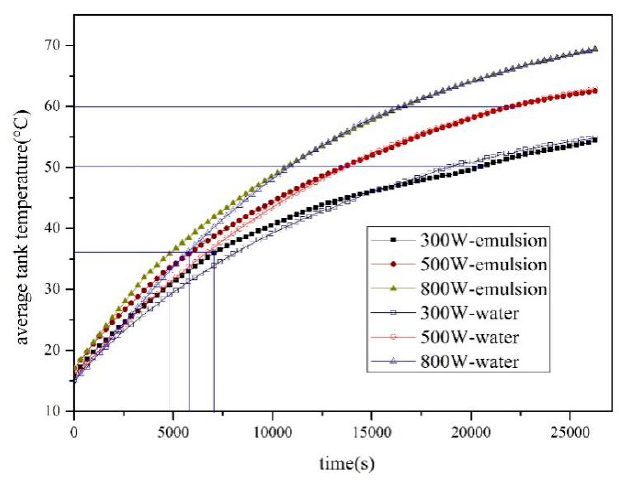
ff erent radiations.